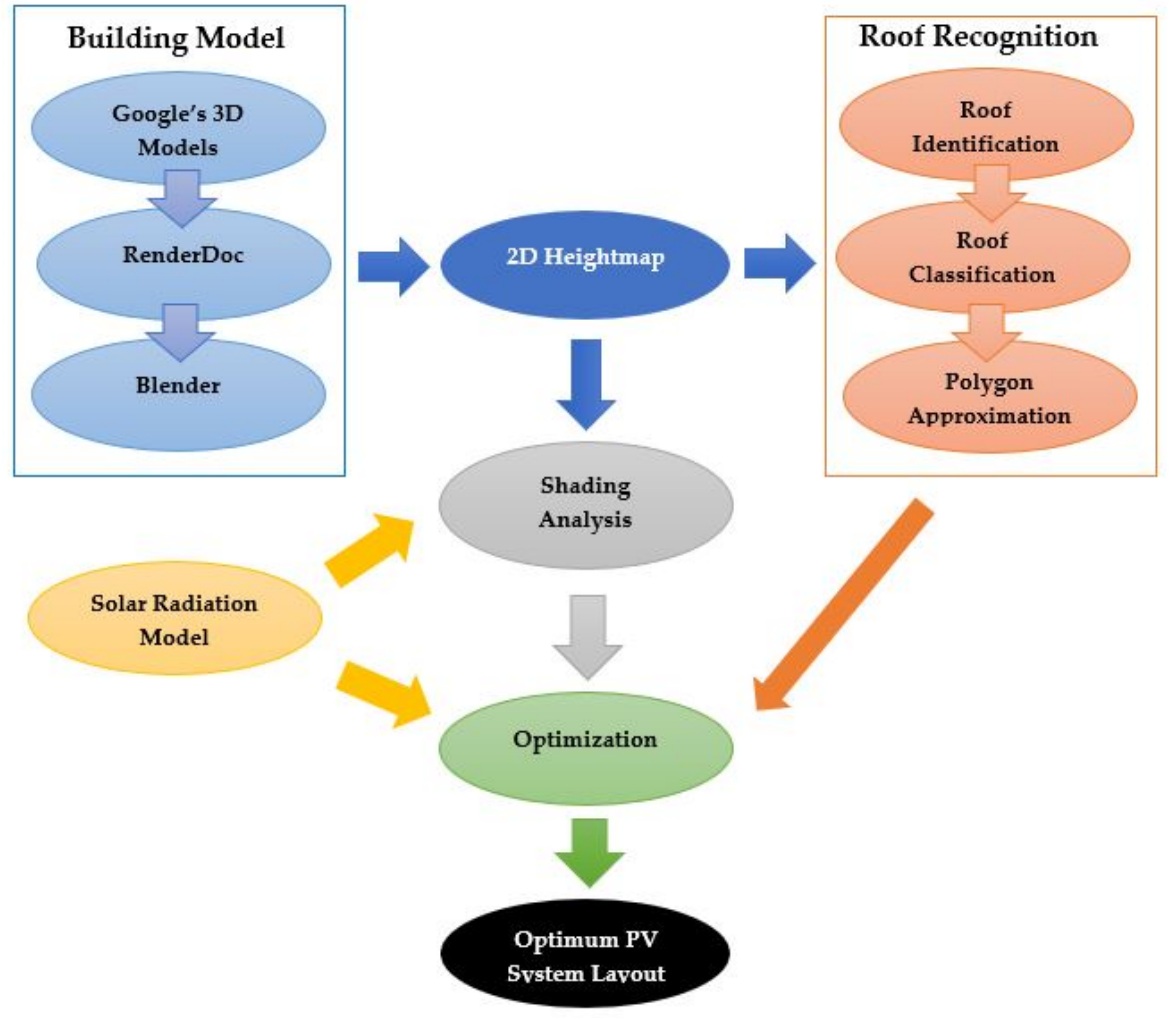
Figure 1. General procedure of the current study.